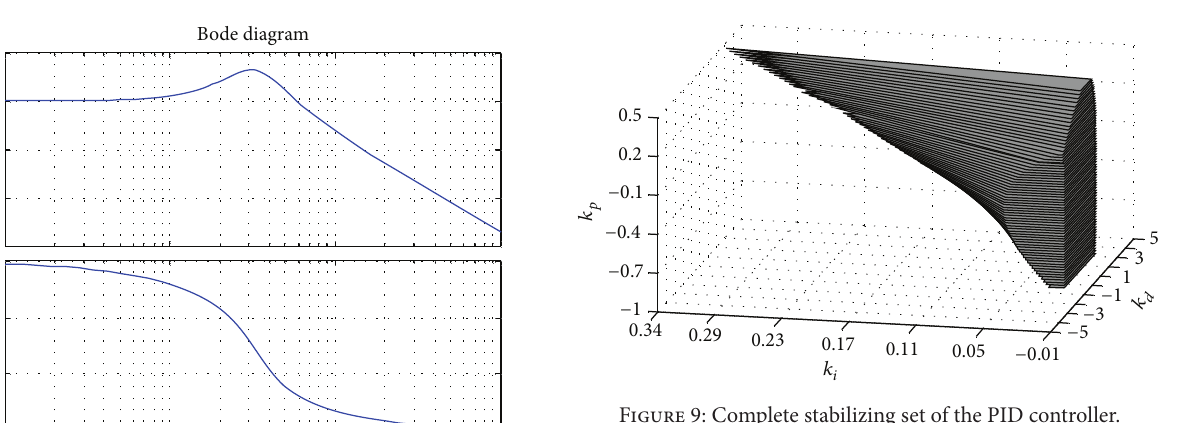
Figure 9: Complete stabilizing set of the PID